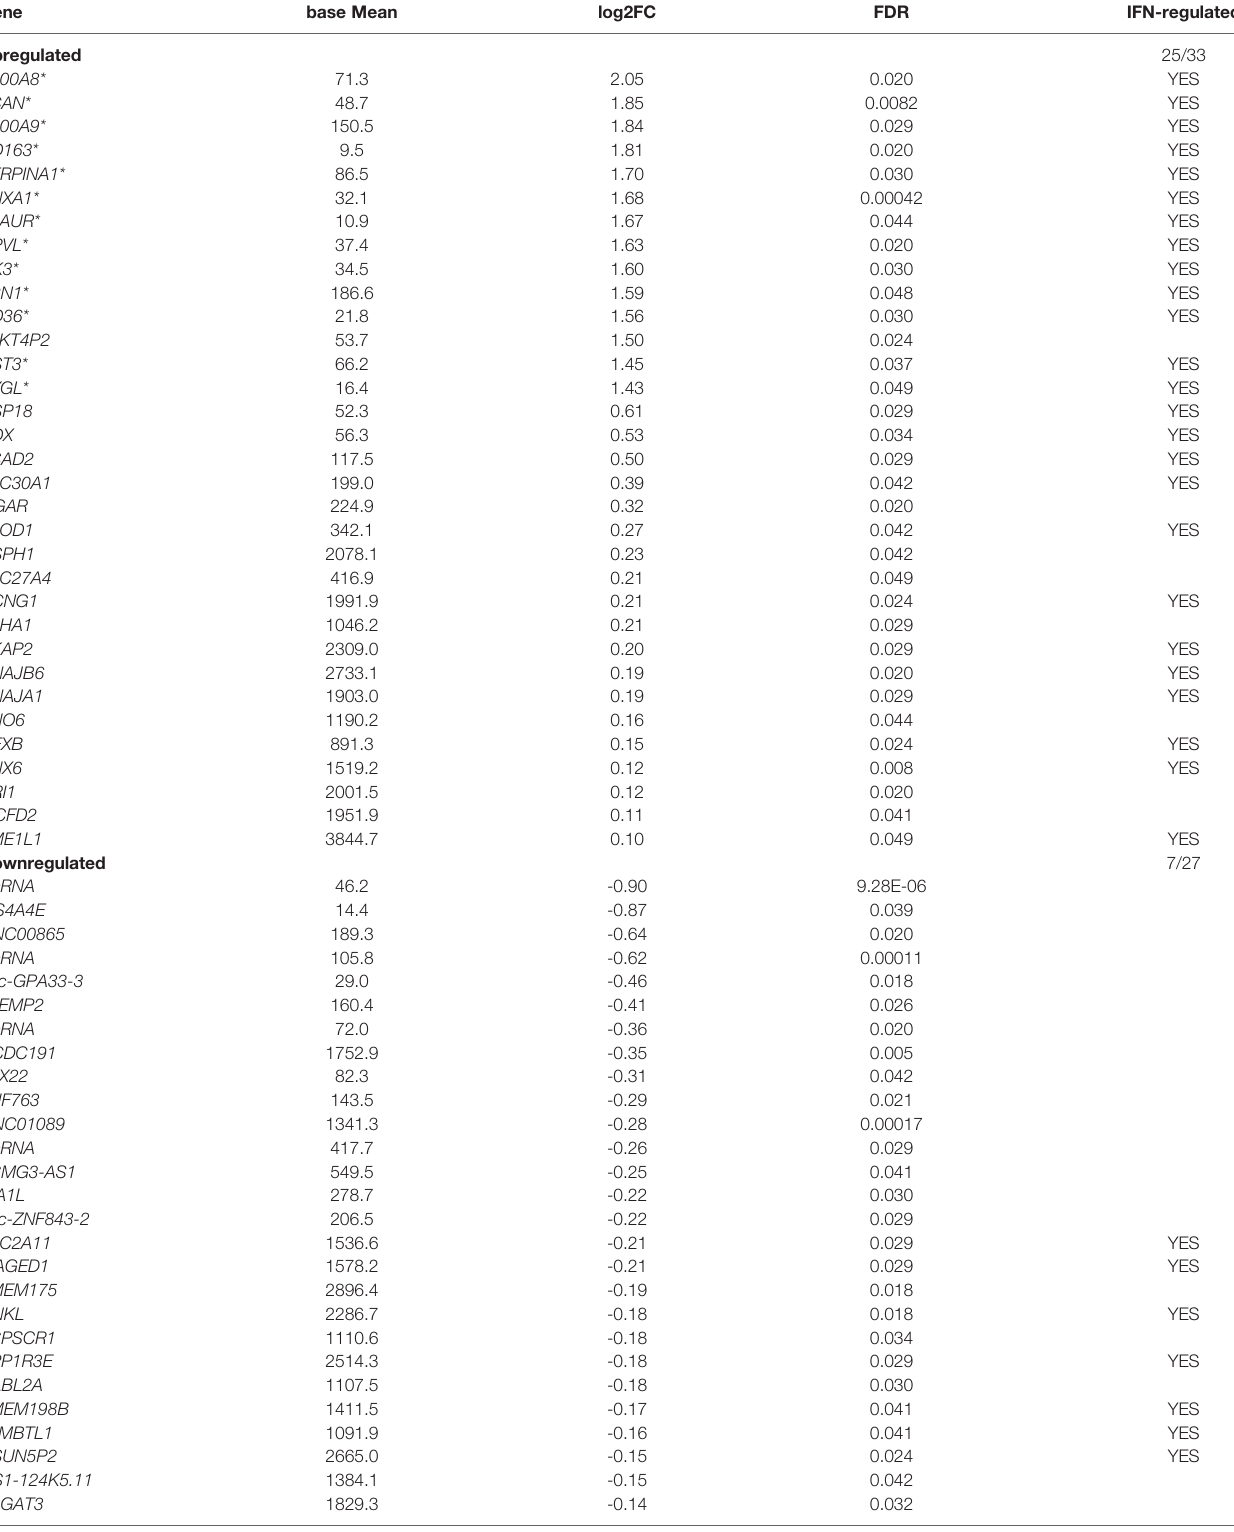
TABLE 1 | Differentially expressed genes and transcripts between FM patients and controls. Gene base Mean log2FC FDR IFN-regulated Upregulated 25/33